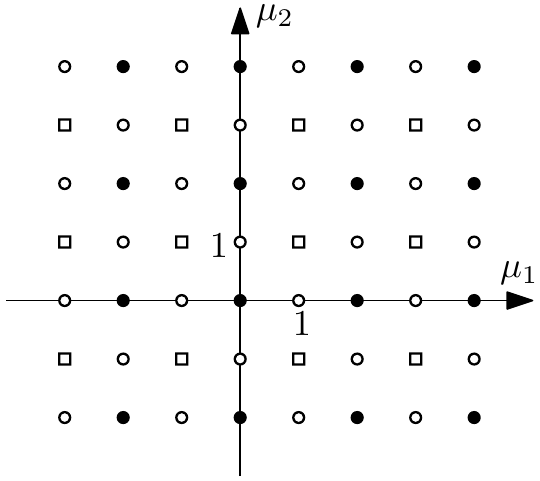
Figure 2 . (cid:22) 1 (cid:0) (cid:22) 2 plane at (cid:12)xed integer D . The quadratic relations exist near any marked point (disk, circle or square). Solid disks correspond to the points where, in addition, the expansion can be expressed via polylogarithms. Depending on whether D is even or odd, the disks correspond to half-integer or integer powers of the propagators. When D is even, integer powers of propagators correspond to empty